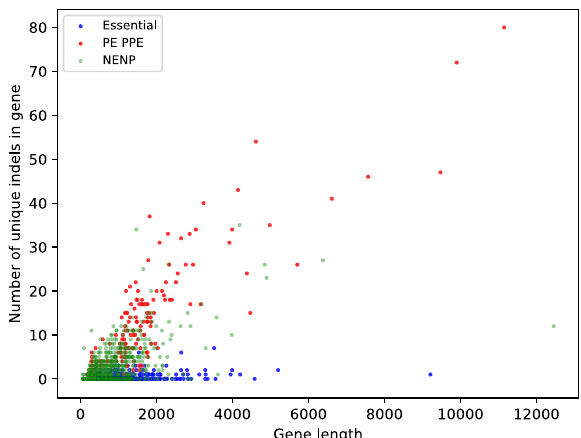
Fig. 3 Indel incidence and gene length. The number of unique indels found in PE-PPE genes (red), in essential genes (blue) and in a random sample of 500 non-essential and non-PE-PPE genes (NENP, faded green) is shown as a function of gene length (nt). The number of unique indels in PE-PPE genes strongly correlate with the gene length, while this correlation is moderate for nonessential and non-PE-PPE genes, and weak for essential